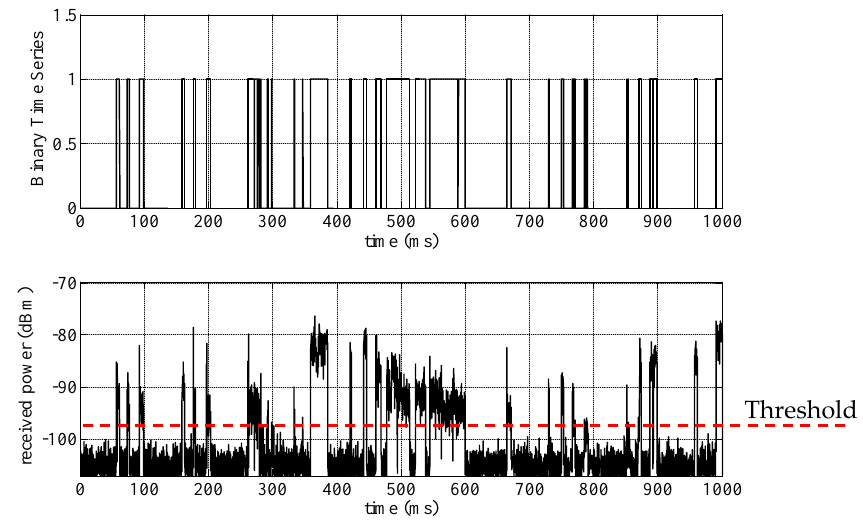
Figure 5. Mapping from received power to Binary Time Series in channel ‘12’.